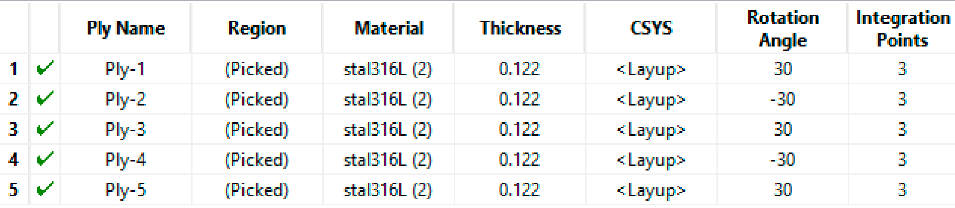
Figure 12. Boundary conditions and load.